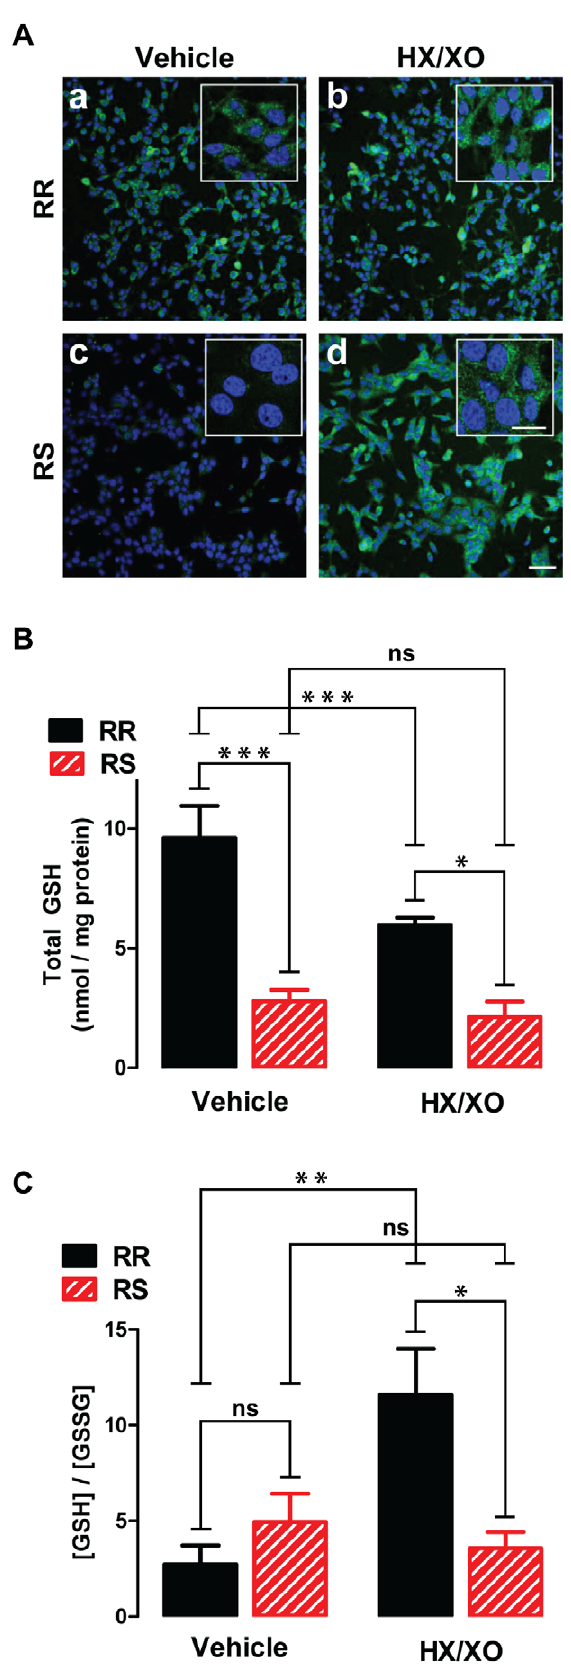
Figure 4. Differential handling of ROS at baseline and following oxidative challenge. A . Immunofluorescence staining for lipid peroxidation marker 4-HNE (green) shows that baseline ROS level is higher in RR cells ( a ) than in RS cells ( b ). After treatment with HX/XO, an increase in 4-HNE staining is seen in RS cells ( d ) but not in RR cells ( c ). Nuclei are visualized by DAPI counter stain (blue). Images were acquired by confocal microscopy; scale bars: 50 m m, main panels; 20 m m, insets. A representative of . 3 independent experiments is shown. B . Total GSH level is higher in RR than RS cells both at baseline and after HX/XO treatment; the oxidative challenge significantly decreased total GSH in RR cells only. C . GSH/GSSG ratio is not significantly different between RR and RS cells at baseline. Following HX/XO treatment, it increased in RR cells but did not change in RS cells, resulting in a significant difference between the two cell types. In all experiments, HX/XO treatment consisted of 0.5 mM HX and 16 U/L XO and was applied for 1 h. In B and C, statistical significance was determined by two-way ANOVA followed by ad-hoc Bonferroni post-tests (n=3–4); all data are plotted as mean 6 S.E.M. *, p ,